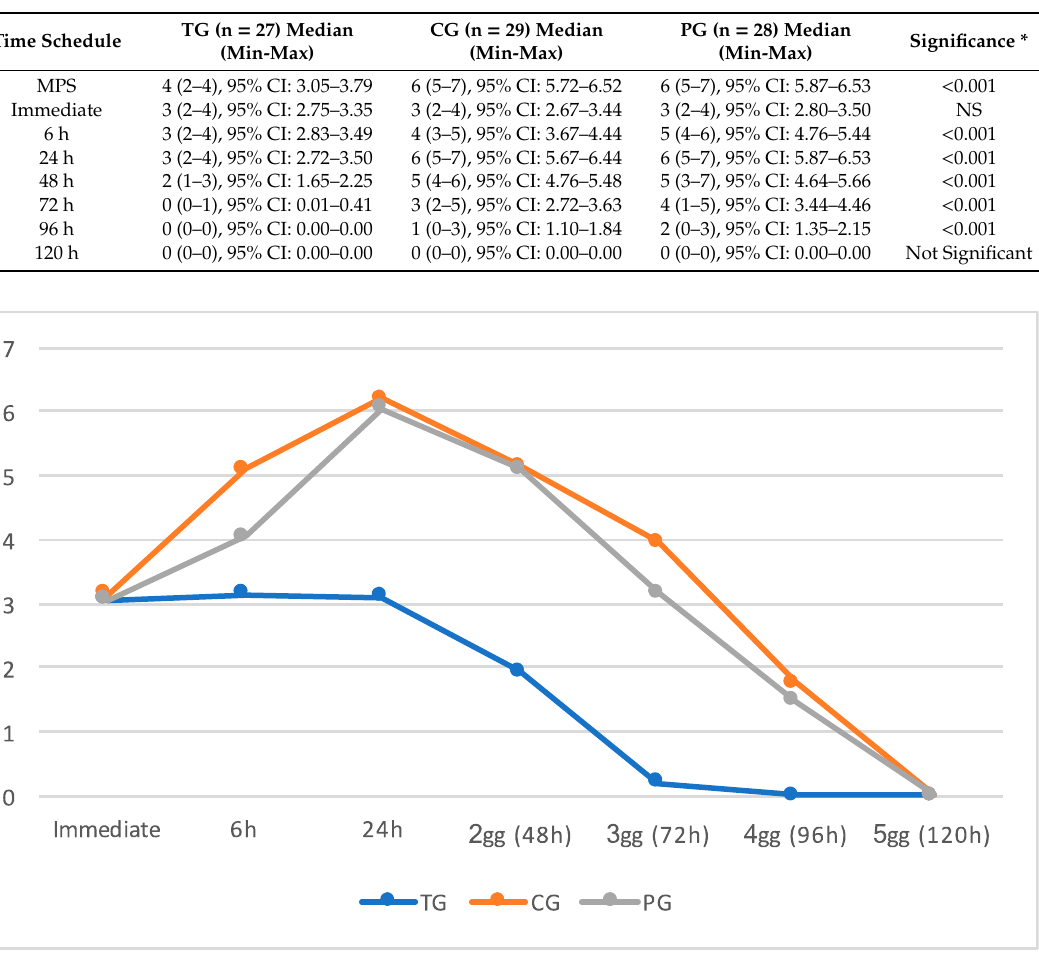
Table 2. The maximum pain score and pain experienced at each schedule, assessed via the Numeric Rating Scale (NRS). TG = Tested group, CG = Control Group, PG = Placebo Group. MPS = Maximum